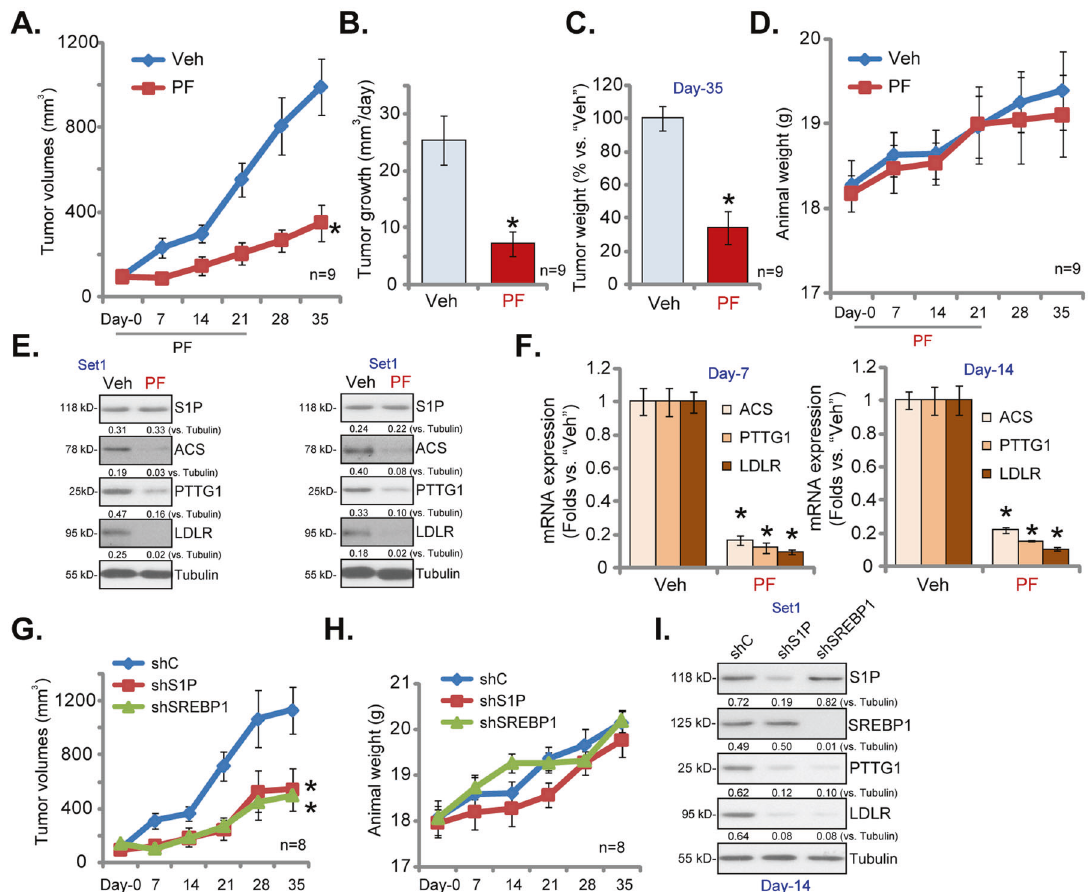
Fig. 5 PF-429242 inhibits subcutaneous RCC xenograft growth in mice. RCC1 xenograft-bearing SCID mice were subjected to i.v . injection of PF-429242 ( “ PF ” , at 10 mg/kg body weight, daily, for 21days) or vehicle control ( “ Veh ” ), tumor volumes ( A ) and mice body weights ( D ) were recorded every seven days; The estimated daily tumor growth, in mm 3 per day, was calculated using the described formula ( B ). On Day-35 tumors of the two groups were separated through surgery and individually weighted ( C ). On Day-7 and Day-14, one tumor of each group was isolated and homogenized in tissue lysis buffer, expression of listed genes was shown ( E and F ). RCC1 xenograft-bearing SCID mice were subjected to intratumoral injection of SREBP1 shRNA lentivirus ( “ shSREBP1 ” ), S1P shRNA lentivirus ( “ shS1P ” ) or scramble control